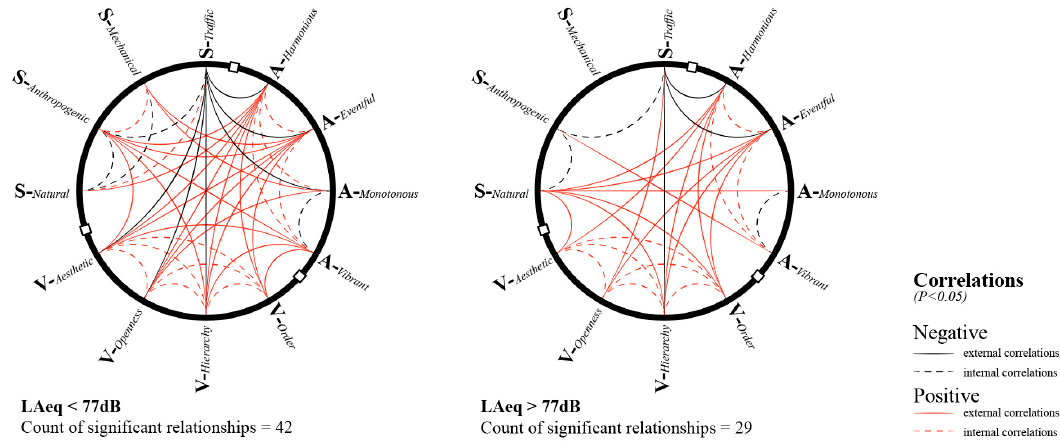
Figure 4. Cross effects of visual and acoustic attributes and sound sources.